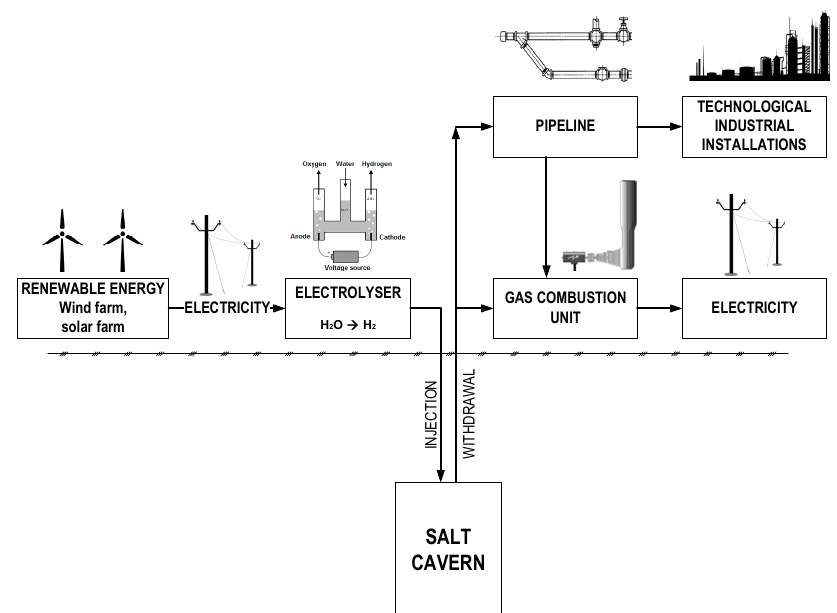
Figure 1. Scheme of hydrogen energy storage processes.